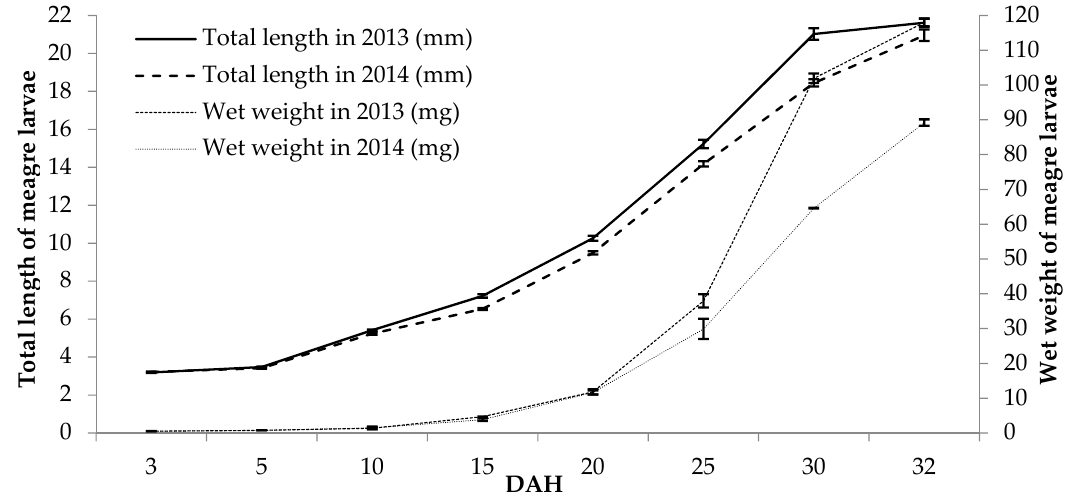
Figure 1. Total length and wet weight changes of meagre larvae (mm and mg, mean ± standard error (SE), n = 30) (0 to 15 days after hatching (DAH) = 364.8 °C, 16 to 32 DAH = 353.6 °C, Σ °C=718.6 °C in 2013 and 0 to 15 DAH = 348.6 °C, 16-32 DAH=353.6 °C, Σ °C=702.2 °C in 2014).